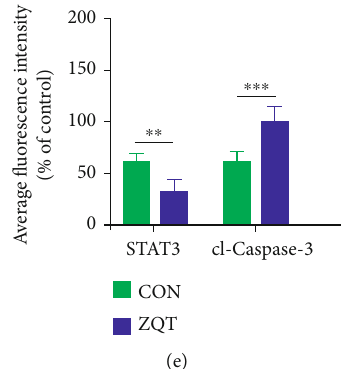
Figure 6: ZQT selectively induced G-MDSC apoptosis by activating the STAT3/S100A9/Bcl-2/caspase-3 signaling pathway. (a) MDSCs from the tumor tissue of tumor-bearing mice treated with normal saline, ZQT, STAT3 inhibitor (S3I-201), or ZQT combined with S3I-201 were isolated using the MojoSort Mouse Isolation Kit. The protein expression of Ki67, STAT1, p-STAT1, STAT3, p-STAT3, S100A9, Arg-1, Bcl-2, Bax, cl-PARP, cyt c, and cl-caspase-3 in MDSCs from both normal saline and ZQT-treated mice was con fi rmed by Western blotting. (b) Lung tumor tissues from normal saline or ZQT-treated tumor-bearing mice were stained using S100A9, Ly6G, Ly6C, CD4, and CD8 antibodies for IHC assay (scale bar: 50 μ M). (c) T-lymphocyte proliferation assay was used to show dose-dependent suppression of T cell proliferation by G-MDSCs isolated from tumor tissue of tumor-bearing mice treated with normal saline or ZQT. CD3 + T cells isolated from tumor stained with 5 μ M CFSE were incubated with G-MDSCs for 72h. Meanwhile, CD3 and CD28 antibodies were added for CD3 + T cell stimulation. Flow cytometry was used to quantify 72 h CFSE dilution. (d, e) G-MDSCs from tumor tissue of tumor- bearing mice treated with normal saline or ZQT were isolated using fl ow cytometry. The purity (CD11b + Ly6G + ) was > 90% as assessed, and the protein expression of STAT3 and cl-caspase-3 was determined by IF (scale bar: 20 μ M). n = 5 . Data are expressed as the mean ± SD . n/s: nonstatistical signi fi cance. ∗ p < 0 : 05 ; ∗∗ p < 0 : 01 ; ∗∗∗ p < 0 : 001